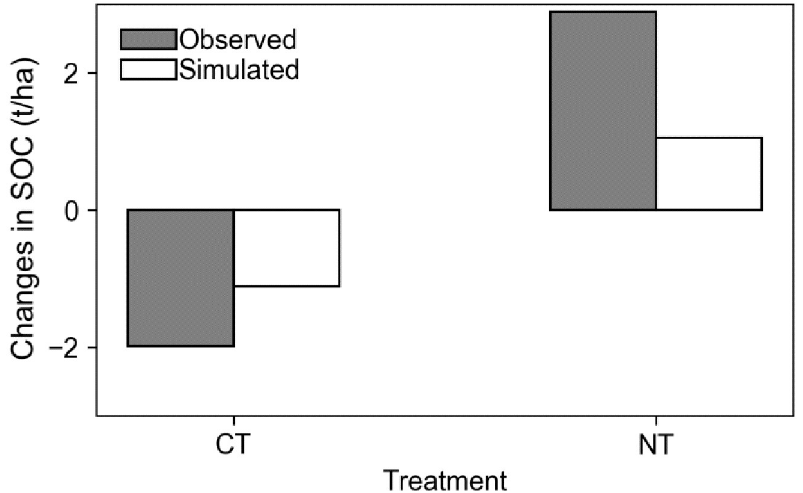
Fig 4. Comparisons between simulated SOC changes in 1989–2006 and observed change in 1988–2006 in the maize-soybean-wheat rotation system under conventional (CT) and no-till (NT) treatments at the Kellogg Biological Station (the observation was from